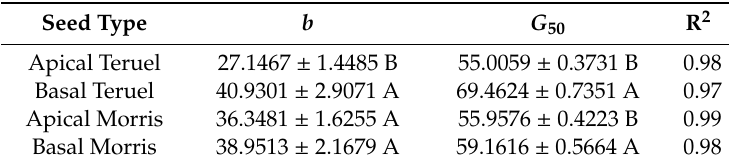
Table 3. Model parameters for the Boltzmann function applied to the normalized germination percentages in Figure 2; Figure 3 to the apical and basal seeds from Teruel and Morris produced in Morris (Minnesota), and the corresponding R 2 for the developed model. The standard error for each parameter is provided, as well as the results of the comparison between apical and basal seeds for each seed population (Teruel and Morris). Di ff erent letters denote significant di ff erences ( p <